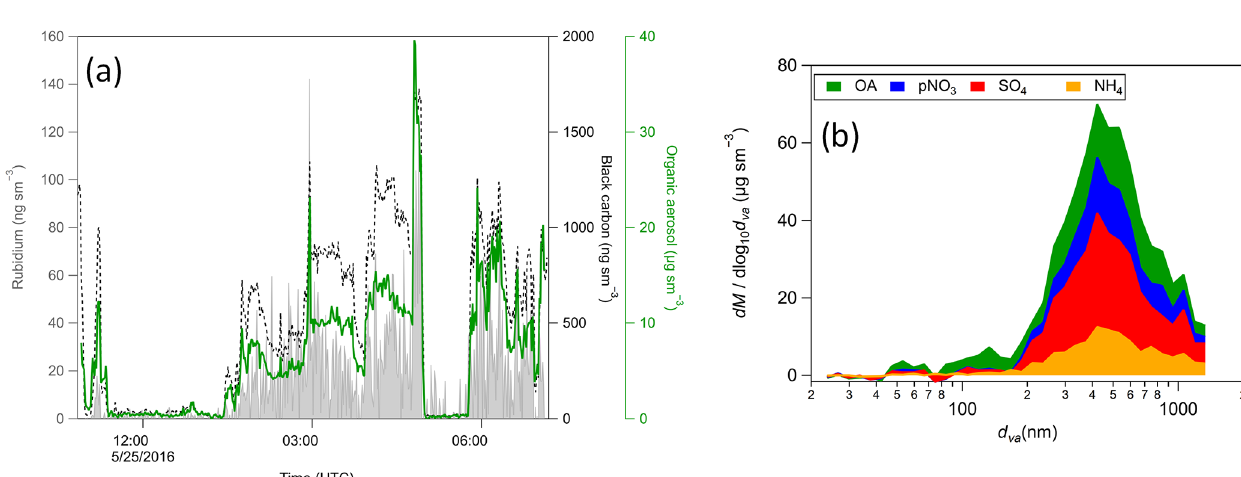
Figure 4. (a) Time series of rubidium (grey, left axis, measured by the AMS), black carbon (black dashed line, right axis, measured by SP2), and total organic aerosol (green, right axis, measured by AMS) during the haze event sampled by the NASA DC-8 over the Yellow Sea. Rubidium was quantified using the AMS difference signal, a relative ionization efficiency of 1, and the same collection efficiency as the rest of the submicron aerosol (Nault et al., 2018). (b) Average size-resolved AMS measurements sampled (aerodynamic diameter) by the NASA DC-8 for the same period shown in (a)